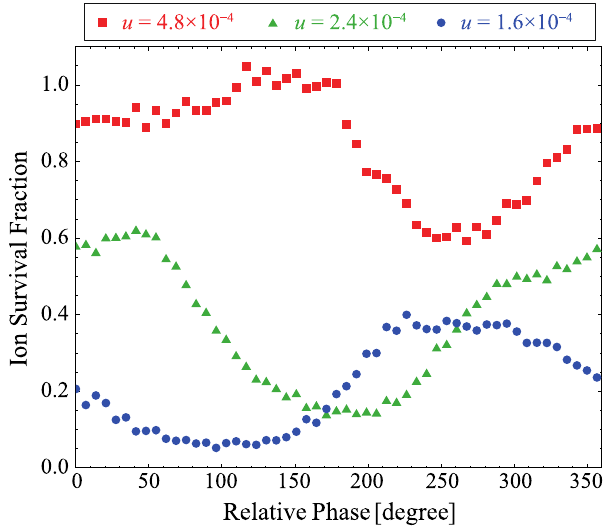
12. Dependence of the ion survival fraction on the relative initial phase of the two sinusoidal dipole perturbations of a fixed strength. Three different speeds of resonance crossing are considered, namely, u ¼ 1 . 6 × 10 − 4 , u ¼ 2 . 4 × 10 − 4 , and u ¼ 4 . 8 × 10 − 4 . The range of tune sweeping is the same as in Fig. 10. The amplitudes of the eighth and ninth dipole harmonics are fixed at 0.2